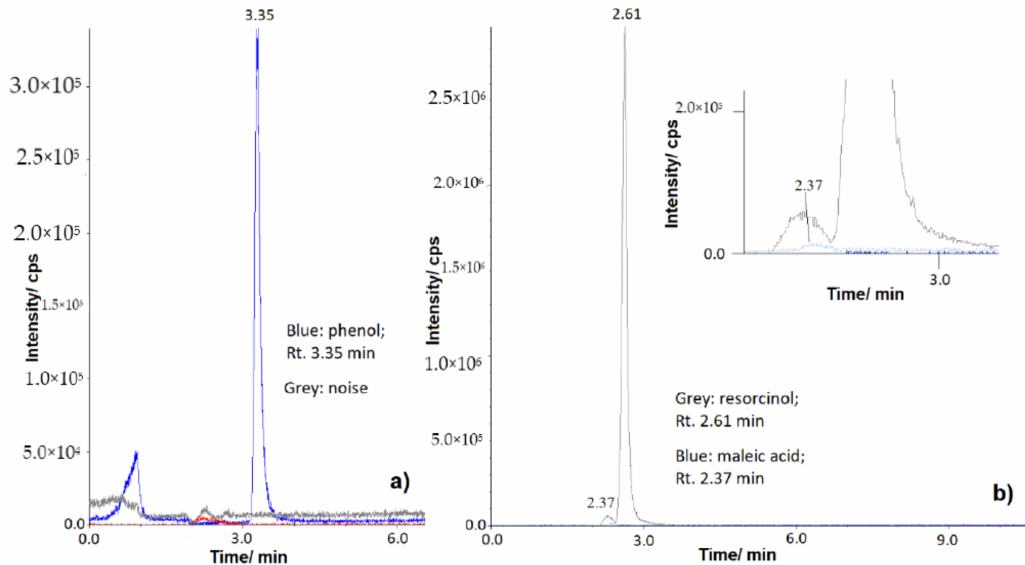
Figure 4. ( a ) HPLC chromatograms recorded for phenol-based, electrolyzed synthetic wastewater solution (Sample 1 ); ( b ) As in ( a ) above, but for resorcinol, exhibiting (scarcely visible) detected maleic acid as an intermediate product of resorcinol electrodegradation (Sample 4 ).